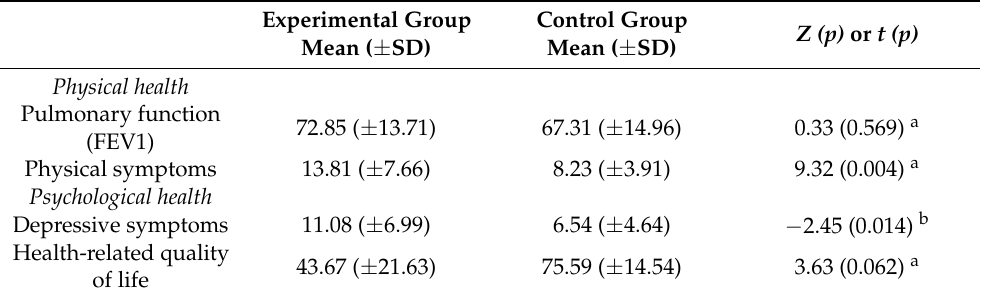
Table 3. Homogeneity of pulmonary function, physical symptoms, depressive symptoms, and health-related quality of life between experimental ( n = 26) and control ( n = 26)